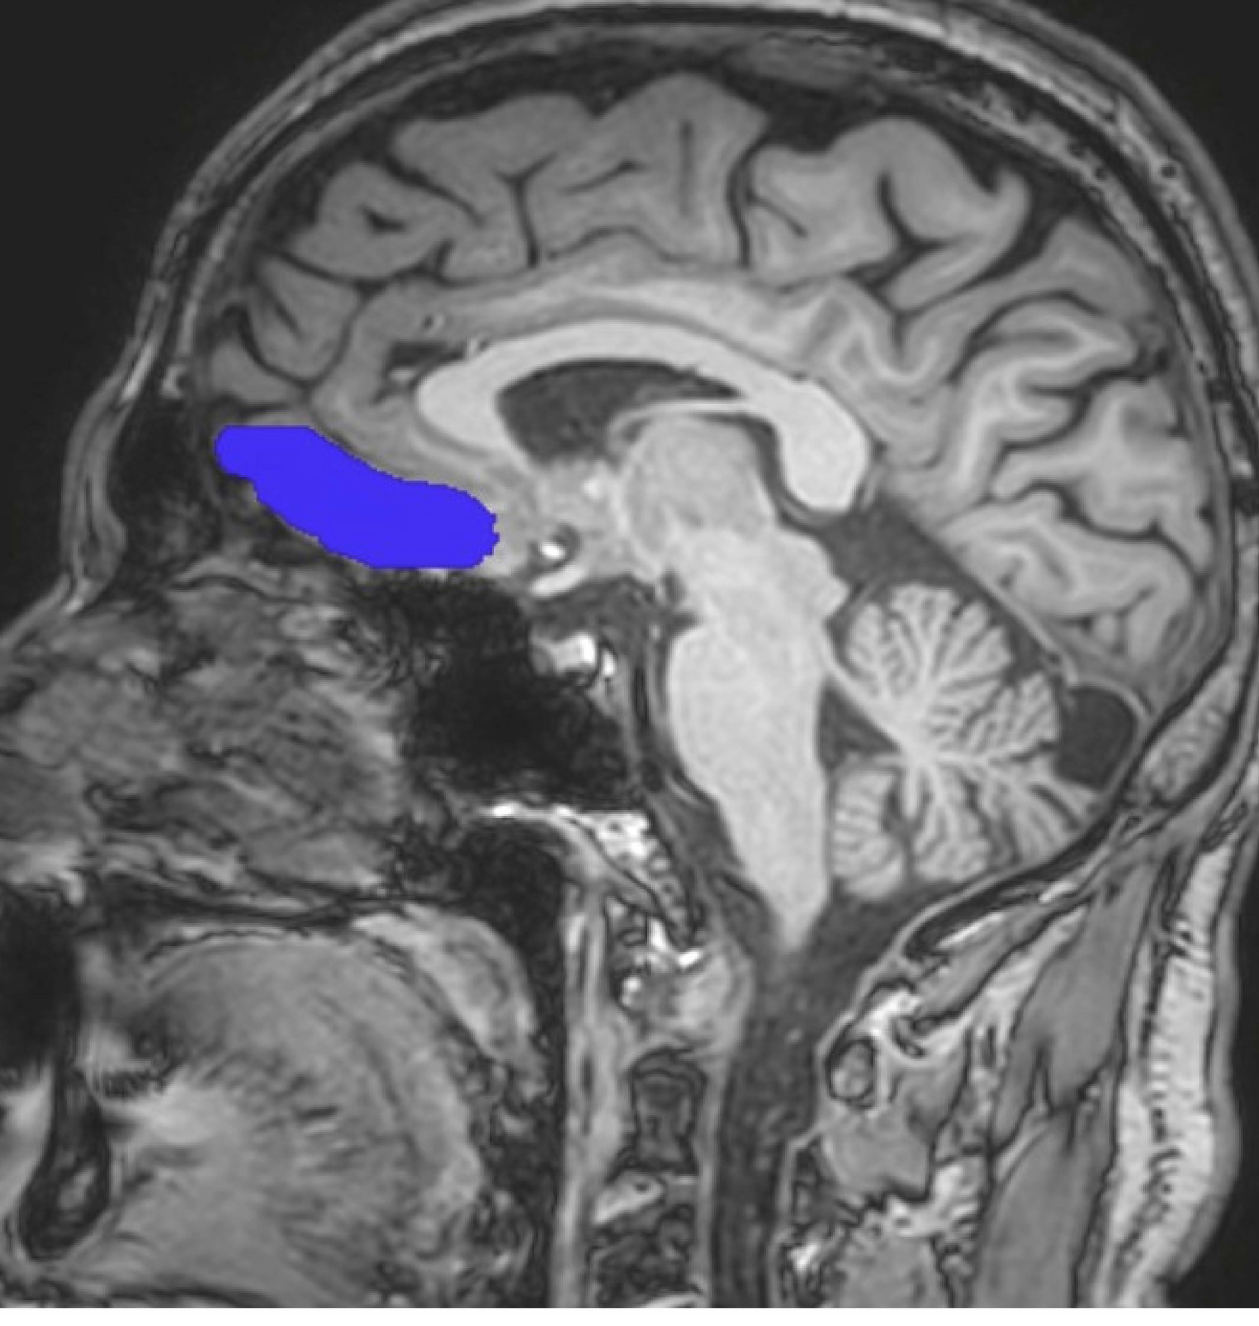
Figure 1. Sample manual tracing for the